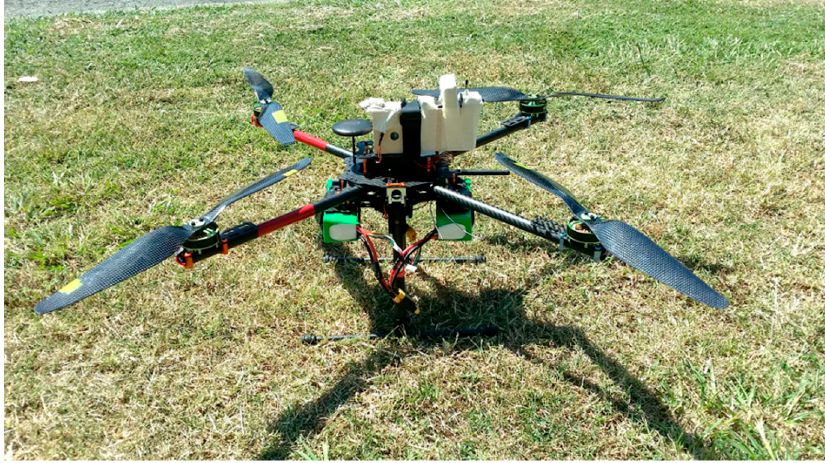
Figure 5. Quadcopter and modular gas-sensor system integrated.